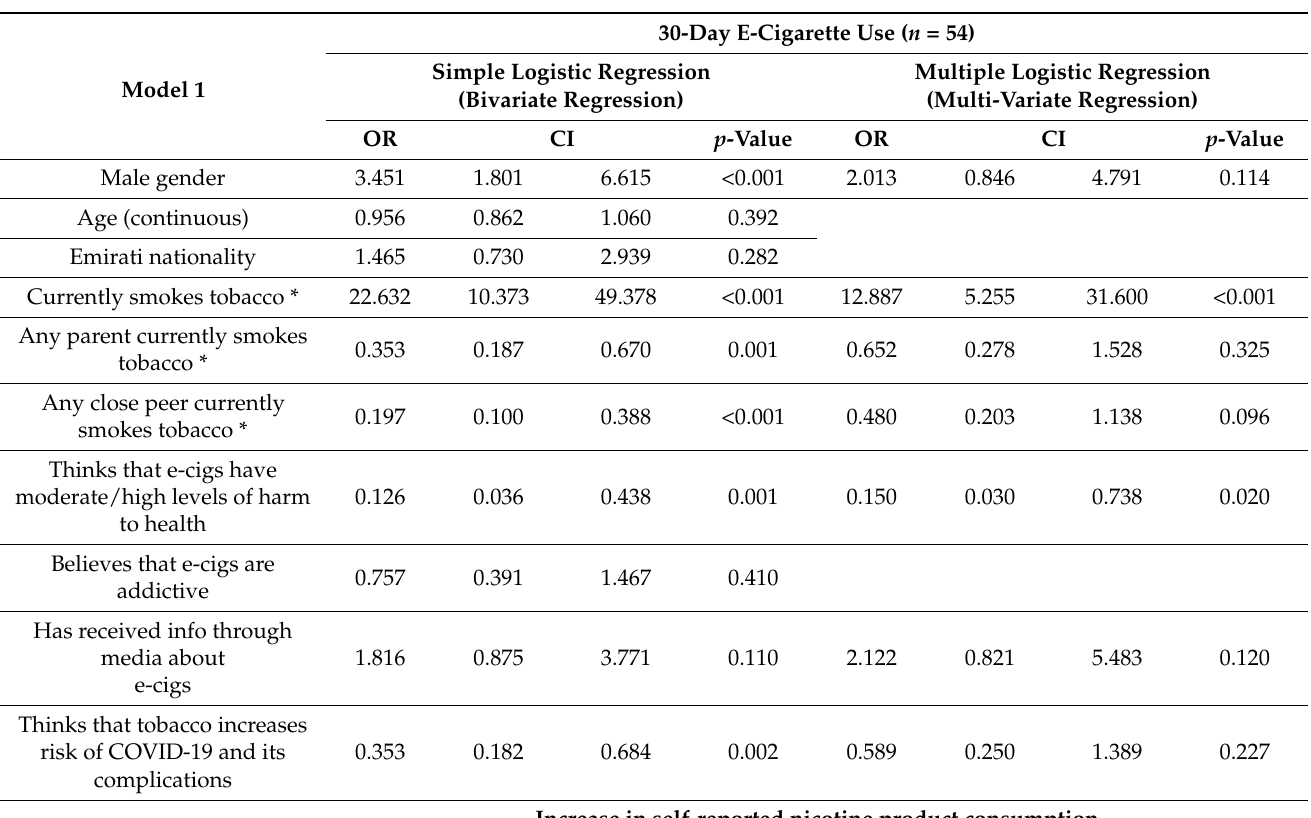
Table 3. Correlates of 30-day e-cigarette use and increase in consumption of nicotine products during the